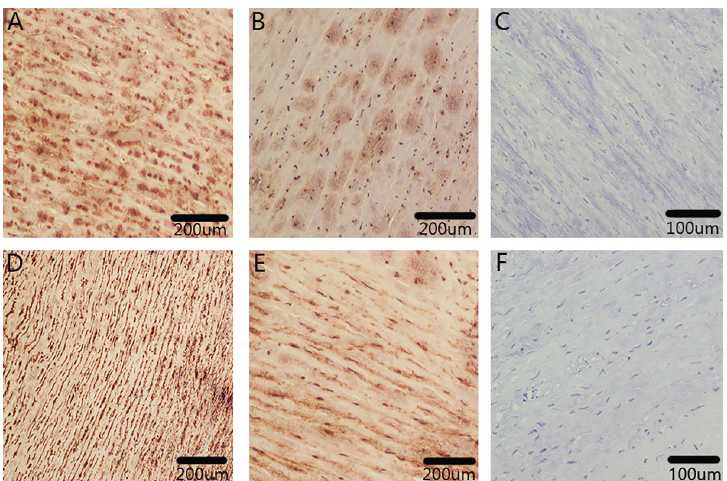
Fig 8. Immunostaining of Ki-67 and CDK1. Immunohistochemical analysis of Ki-67 and CDK1 expression in aortic dissection (n = 5) and control tissue samples (n = 5). A: Strong Ki-67 expression on aortic dissection tissue. B: Weak Ki-67 expression on control tissue. C: Secondary-antibody-only negative control. D: Strong CDK1 expression on aortic dissection tissue. E: Weak CDK1 expression on control tissue. F: Secondary-antibody-only negative control.